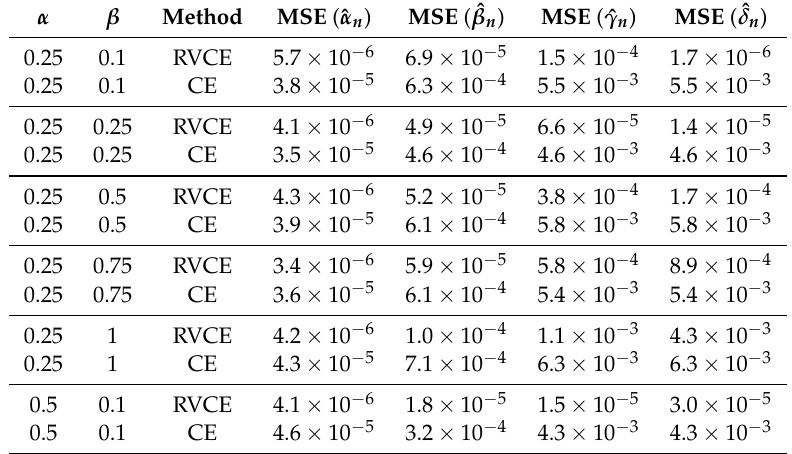
Table B1. The MSEs of reduced values’ cumulant estimates (RVCE) and cumulant estimates (CE)